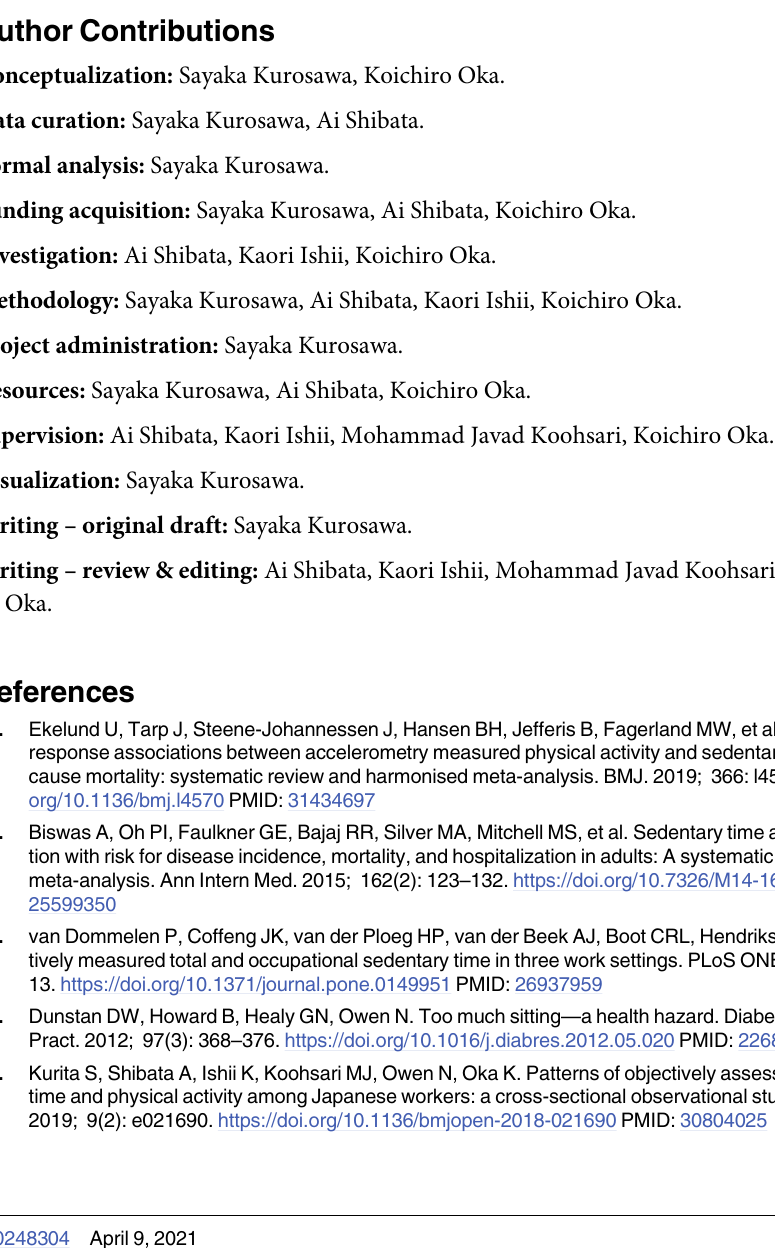
S1 Table. Differences in time-specific sedentary behavior by cluster. SB, sedentary behavior; SD, standard deviation. Using analysis of variance with post hoc Bonferroni multiple compari- son tests, group differences were